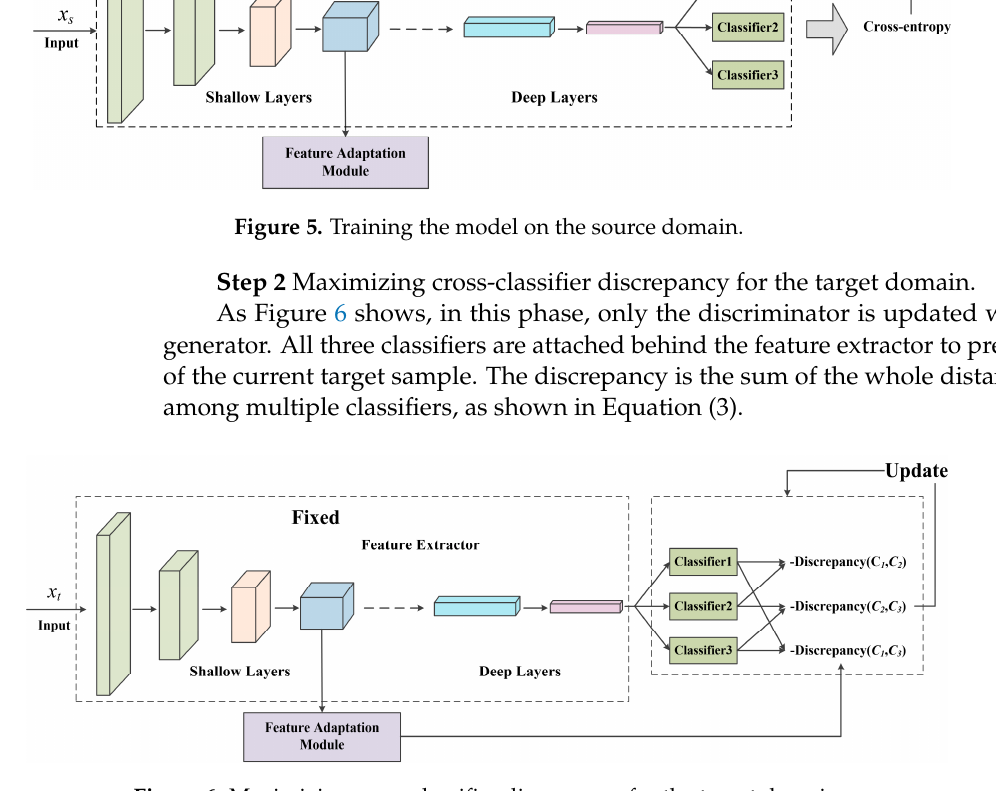
Figure 5. Training the model on the source domain.